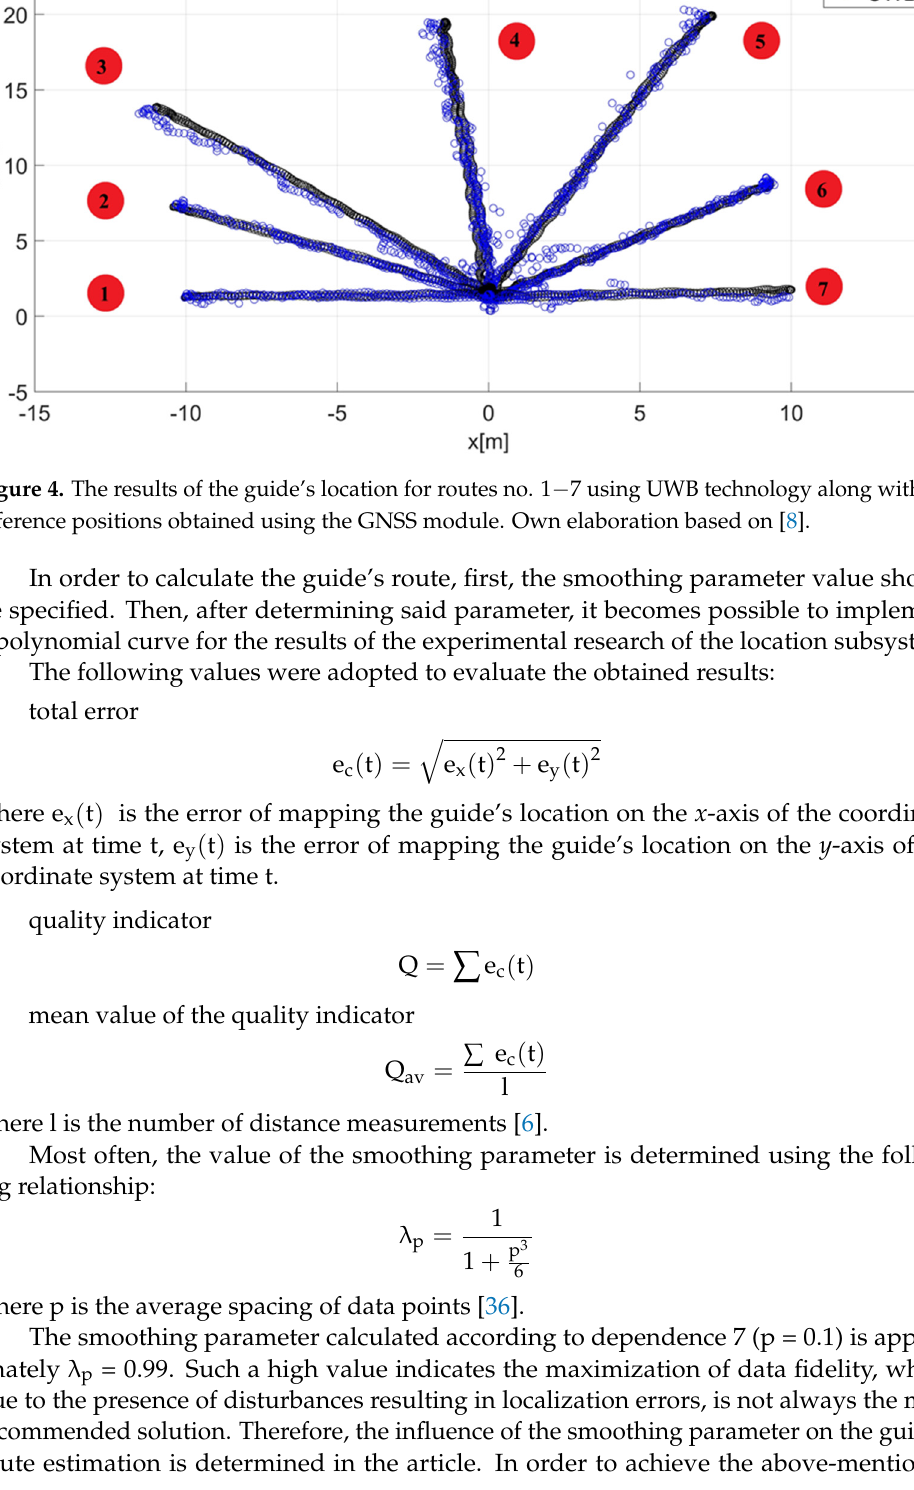
Figure 3. Mobile UWB guide location kit.